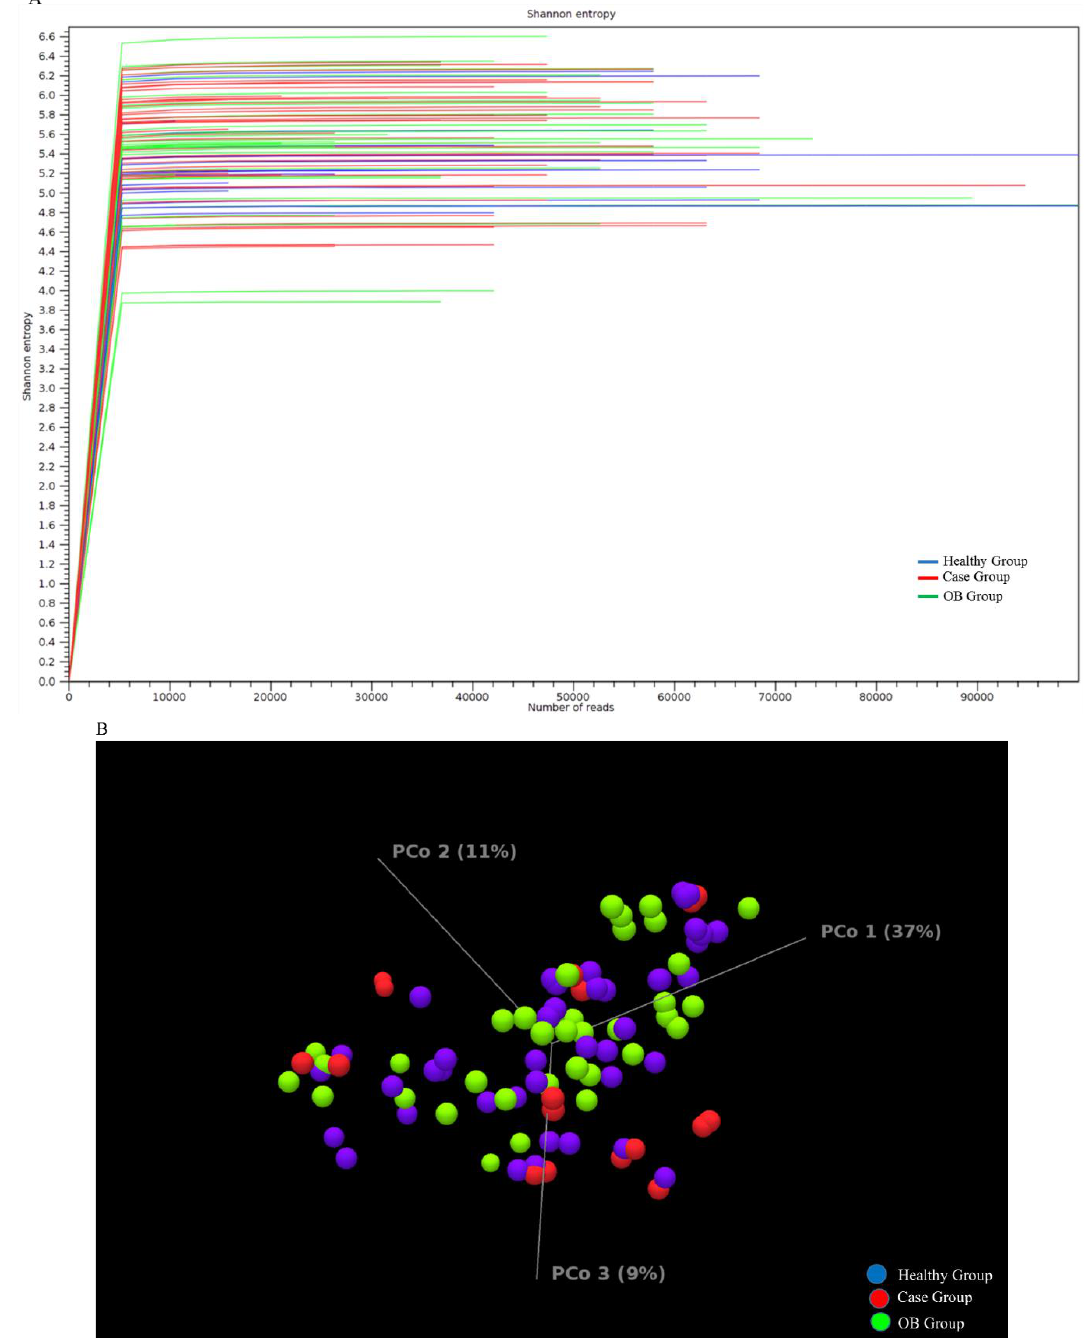
Figure 1. Diversity of taxonomic identification between three groups of participants. ( A ) The α -diversity in all groups was estimated using Shannon indices. ( B ) Weighted Unifrac principal component analysis (PCA) was performed to evaluate the β -diversity in all groups of participants.